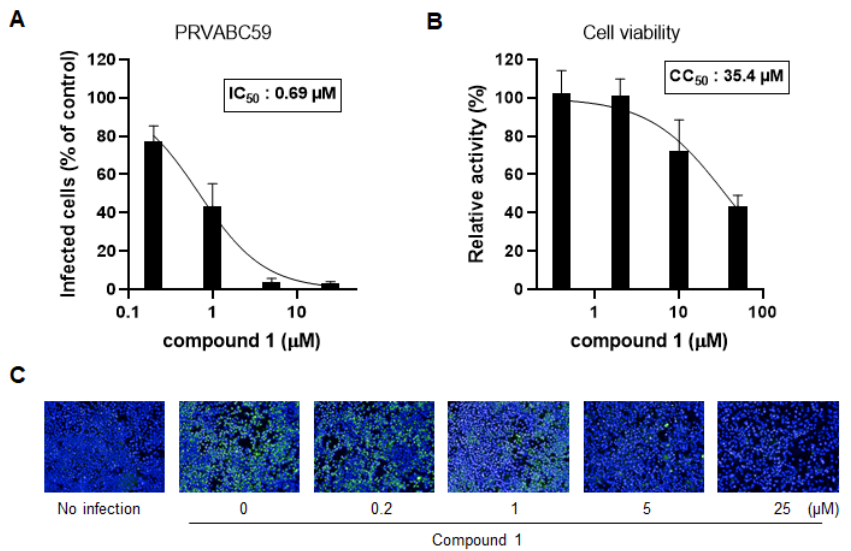
Figure 3. Compound 1 potently inhibits ZIKV infection of Huh7 cells. ( A ) Huh7 cells were treated with increasing concentrations of compound 1 and infected with ZIKV (strain: PRVABC59). After 72 h, infected cells were stained with an anti-dsRNA primary antibody and an Alexa Fluor 488- conjugated secondary antibody. Nuclei were counterstained with Hoechst 33342. Viral infection was calculated by counting the stained cells and the antiviral activity (IC 50 ) was determined from a dose-response curve. ( B ) Huh7 cells were treated with the indicated concentrations of compound 1 without ZIKV infection and analyzed for cell viability using the thiazolyl blue tetrazolium bromide (MTT) assay. ( C ) Representative images of ( A ).